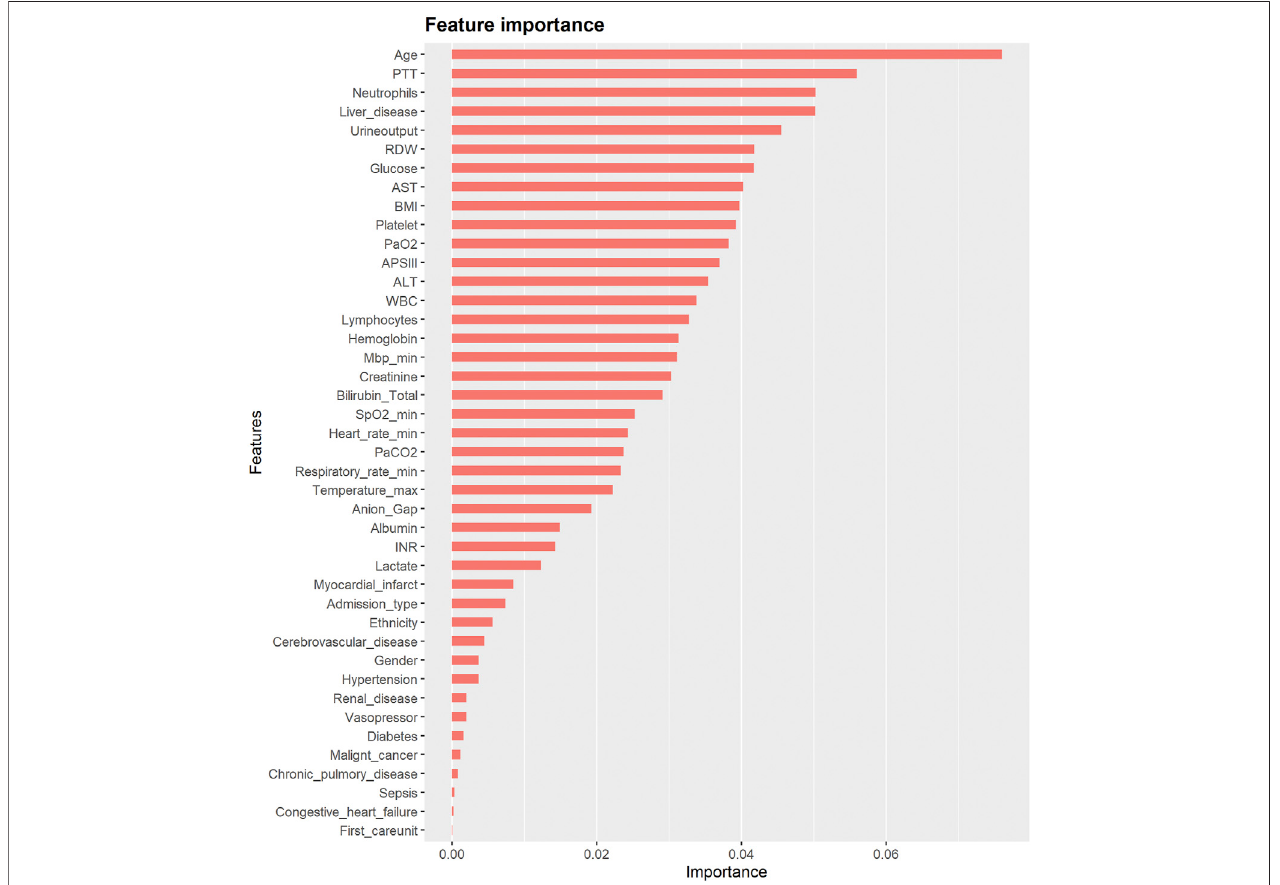
FIGURE 3 | The contribution of each covariate to the XGBoost